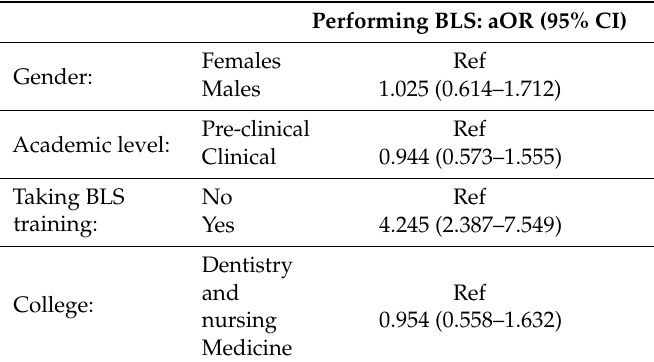
Table 2. Multivariate analysis for factors associated with performing BLS upon encountering a situation that required BLS initiation, among health professions students at King Khalid